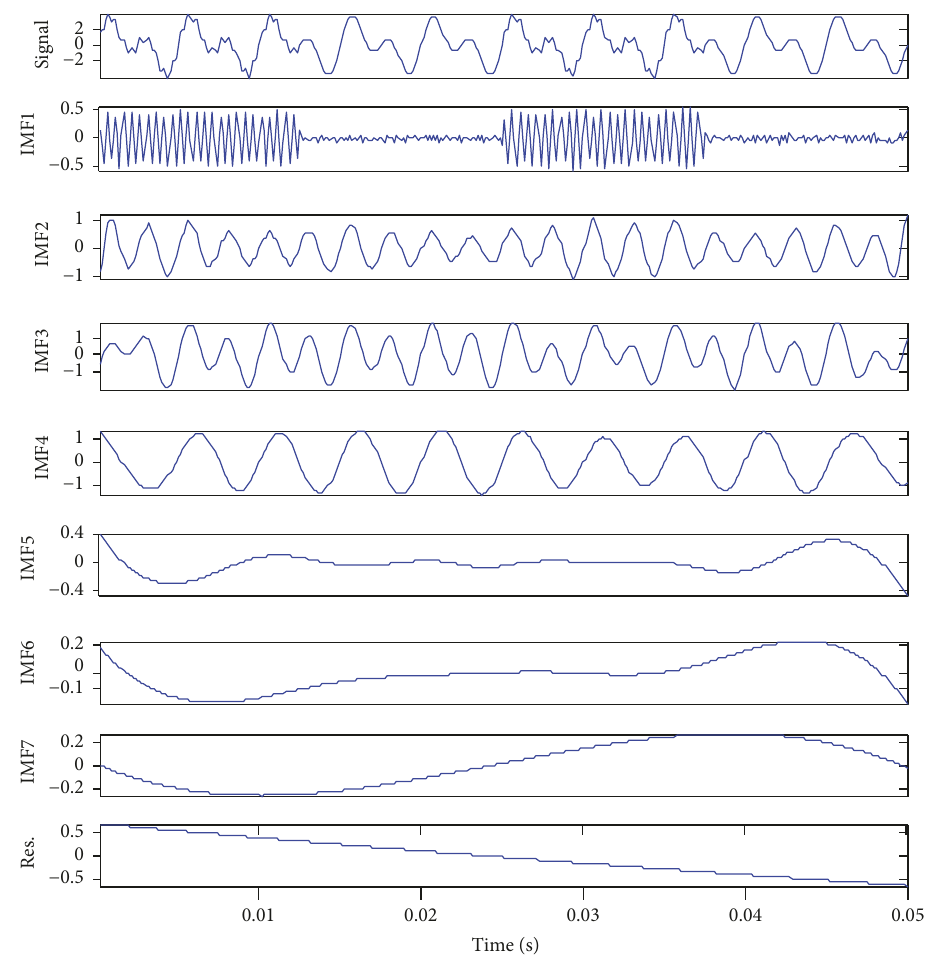
Figure 5: The decomposition results of